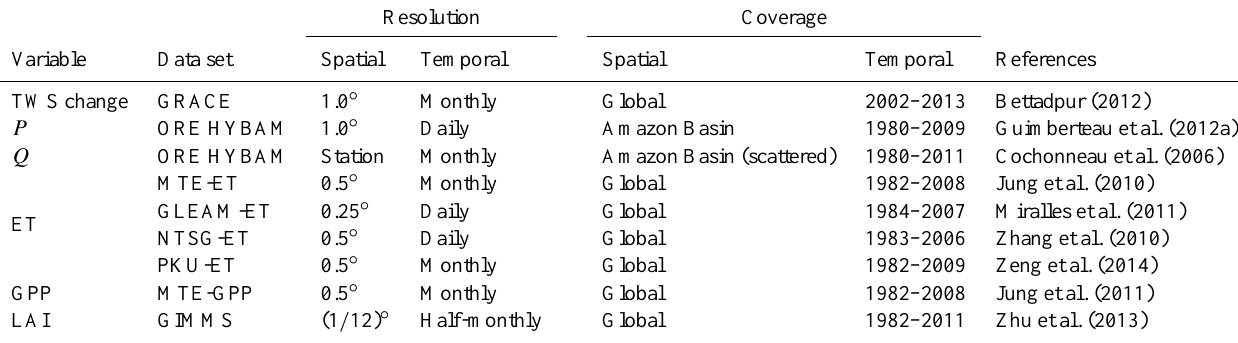
Table 2. List of evaluation data sets.